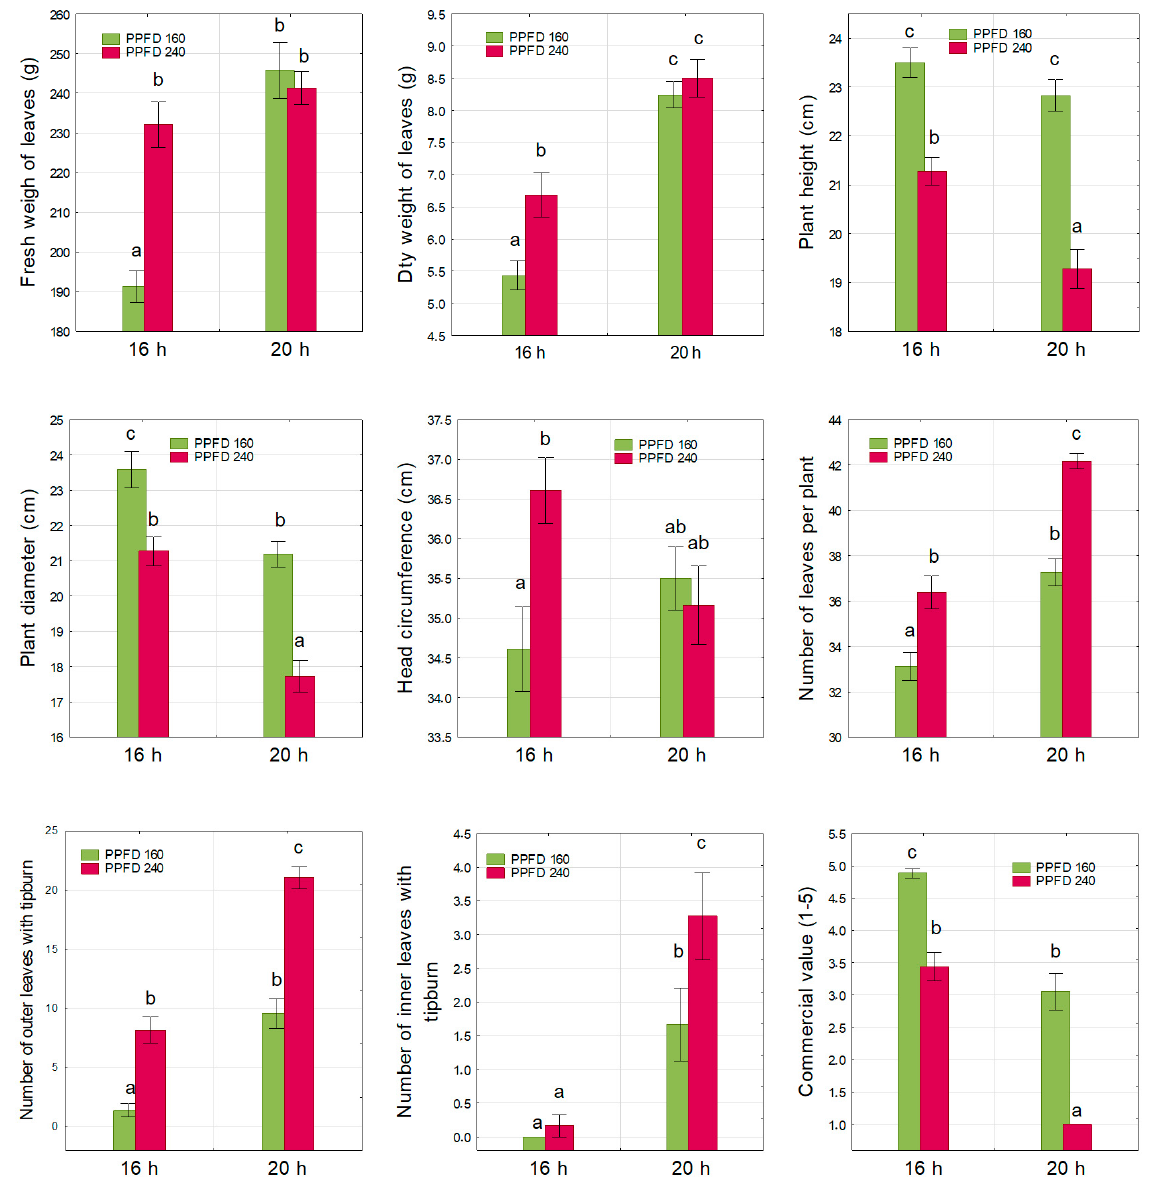
Figure 2. Fresh and dry weight of leaves, plant height, plant diameter, head circumference, number of leaves per plant, number of outer and inner leaves with tipburn, and commercial value of cv. ‘Elizium’ romaine lettuce grown under different light environments (photoperiod 16 and 20 h and PPFD 160 and 240 µmol m − 2 s − 1 ). Bars represent means ± SE. Means followed by the same letter are not significantly different ( p < 0.05) according to Tukey’s HSD test.